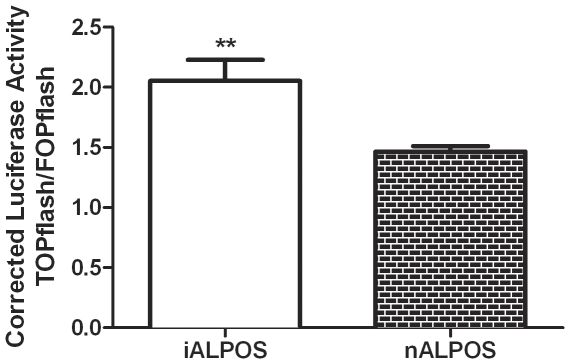
Luciferase Reporter Assay to assess Wnt/β-catenin pathway activity in osteosarcoma cell lines associated with increased (iALPOS) or normal (nALPOS) serum ALP concentration.TOPflash and FOPflash values are corrected to respective Renilla luminescence as a transfection control. iALPOS TOP/FOPflash (2.05±0.17, mean ± SEM) compared to nALPOS TOP/FOPflash (1.47±0.05) (p<0.01 using unpaired two-tailed t-test).